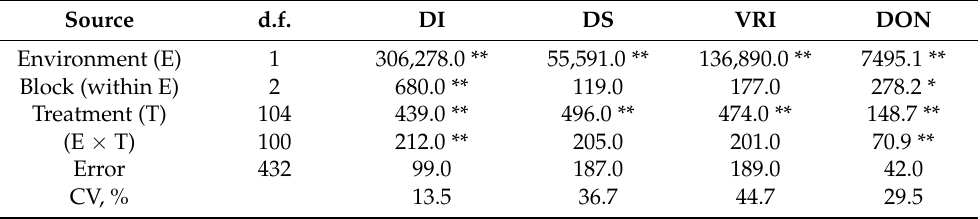
Table 1. ANOVA of four FHB traits: DI; DS, VRI (= DI × DS/100) and DON (in ppm) of parents (TMP16315 and AC Ultima), their progenies (DHs) and checks, grown at Beloeil and Ottawa, during 2011.